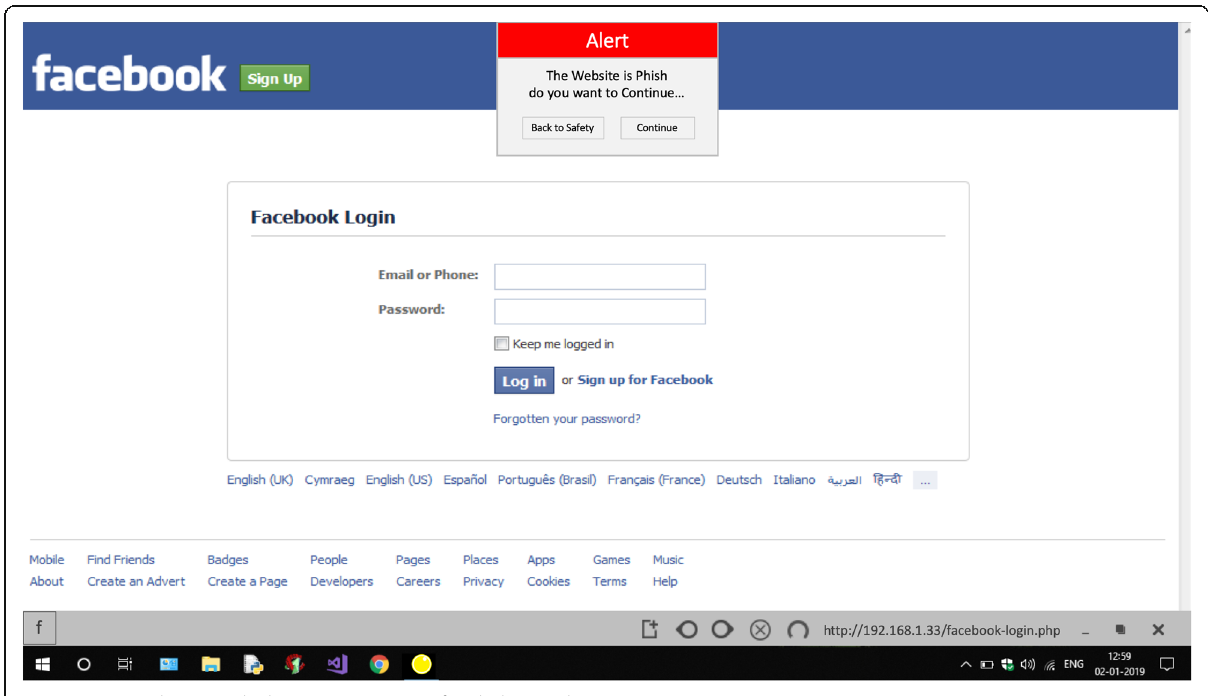
Fig. 8 Prototyped EPDB with alert pop-up message for phishing